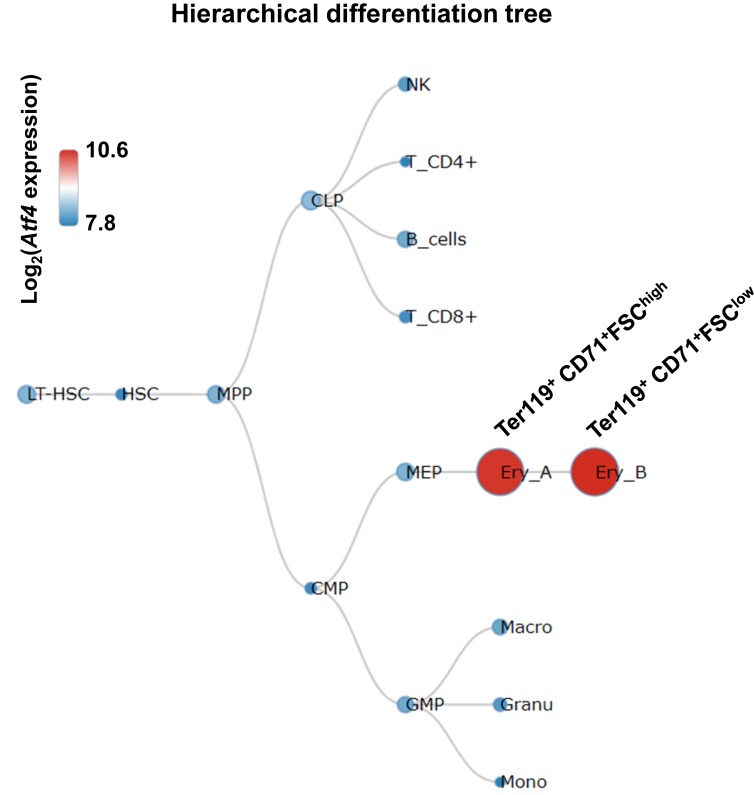
Expression of Atf4 mRNA in hematopoietic cells.The plot of Atf4 expression levels in hematopoietic cells of murine bone marrow was obtained from the BloodSpot database (Bagger et al., 2016). The dataset used for ploting the tree was Mouse Normal RNA-seq, which was derived from the work of Lara-Astiaso et al. (2014). Expression level is log2-transformed and visualized by the size and color of the nodes.